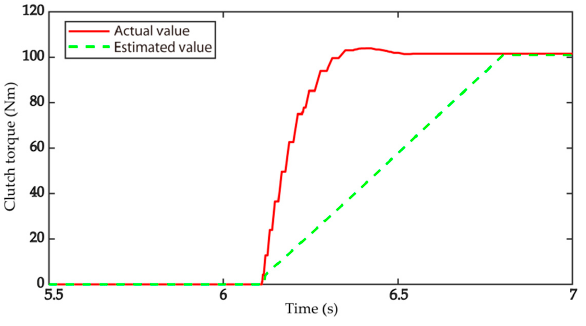
Figure 8. Result of PI observer.